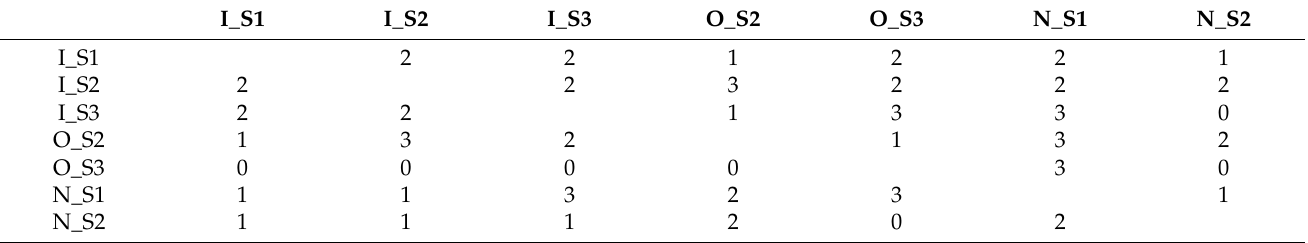
Table A2. Negative cross-impact